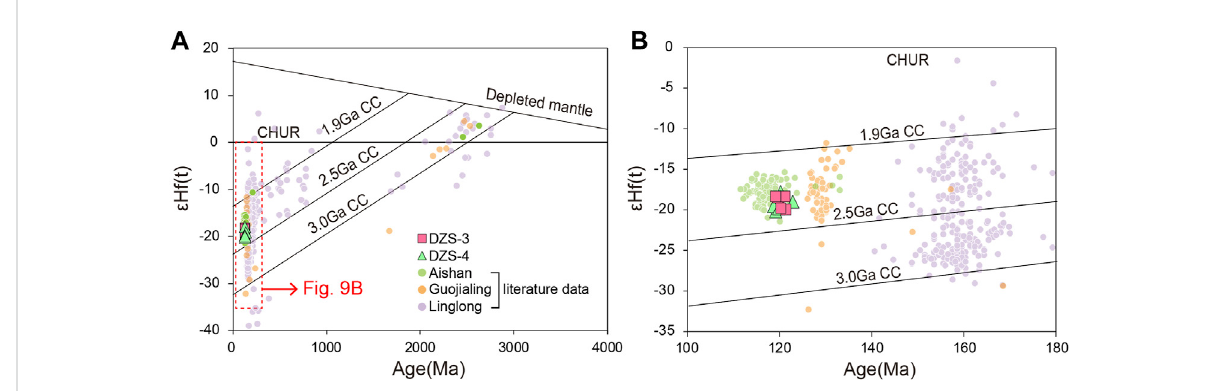
FIGURE 9 Zircon Hf isotopic data from rhyolite porphyry (A) and Dazeshan biotite granite (B) . Published zircon isotope data are compiled from Yang et al. (2012; 2017), Ma et al. (2013; 2014), and Li et al. (2019).